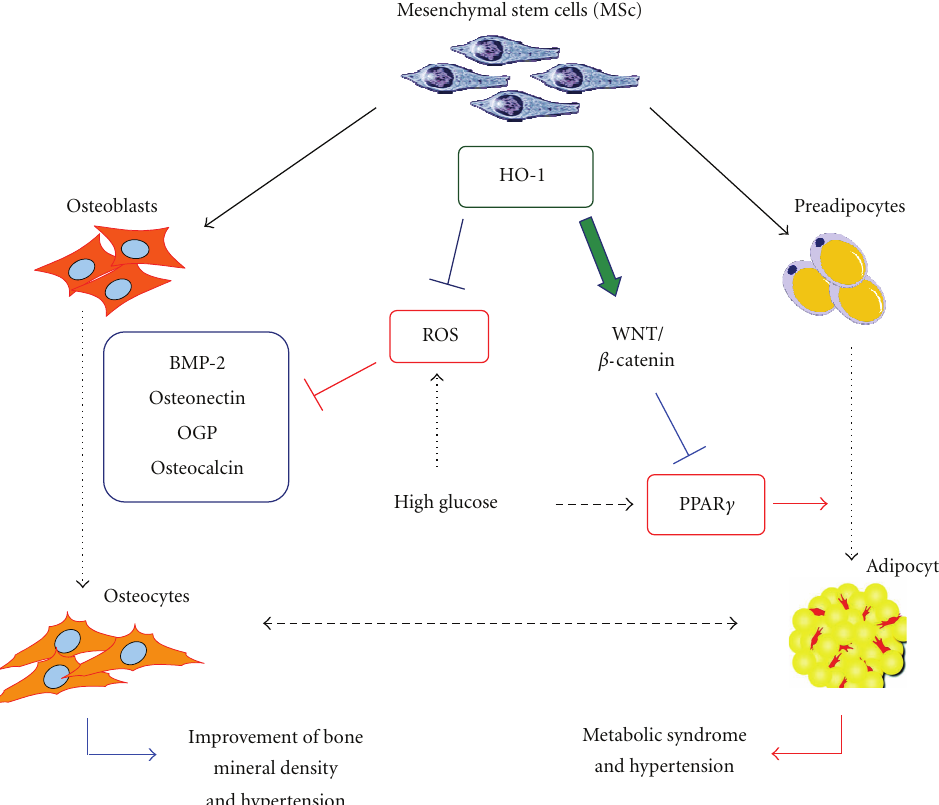
Figure 5: Schematic demonstrating the interplay between HO-1, hyperglycemia, ROS, and PPAR- γ on the regulation of osteoblast and adipocyte di ff erentiation from mesenchymal stem